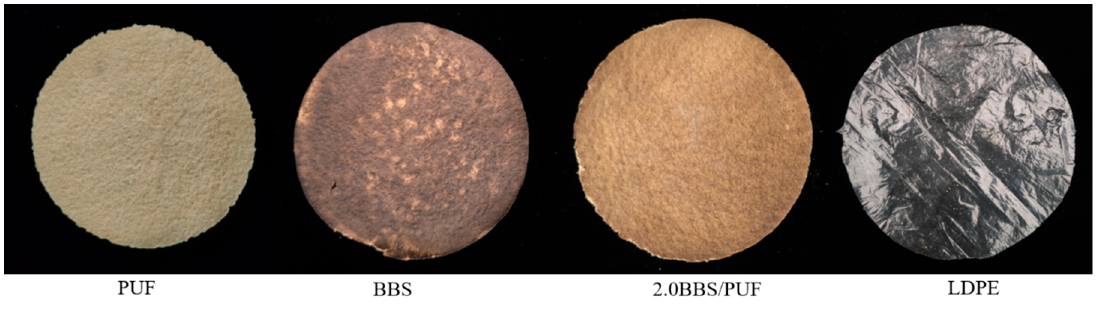
Figure 6. Differently treated mulch samples.